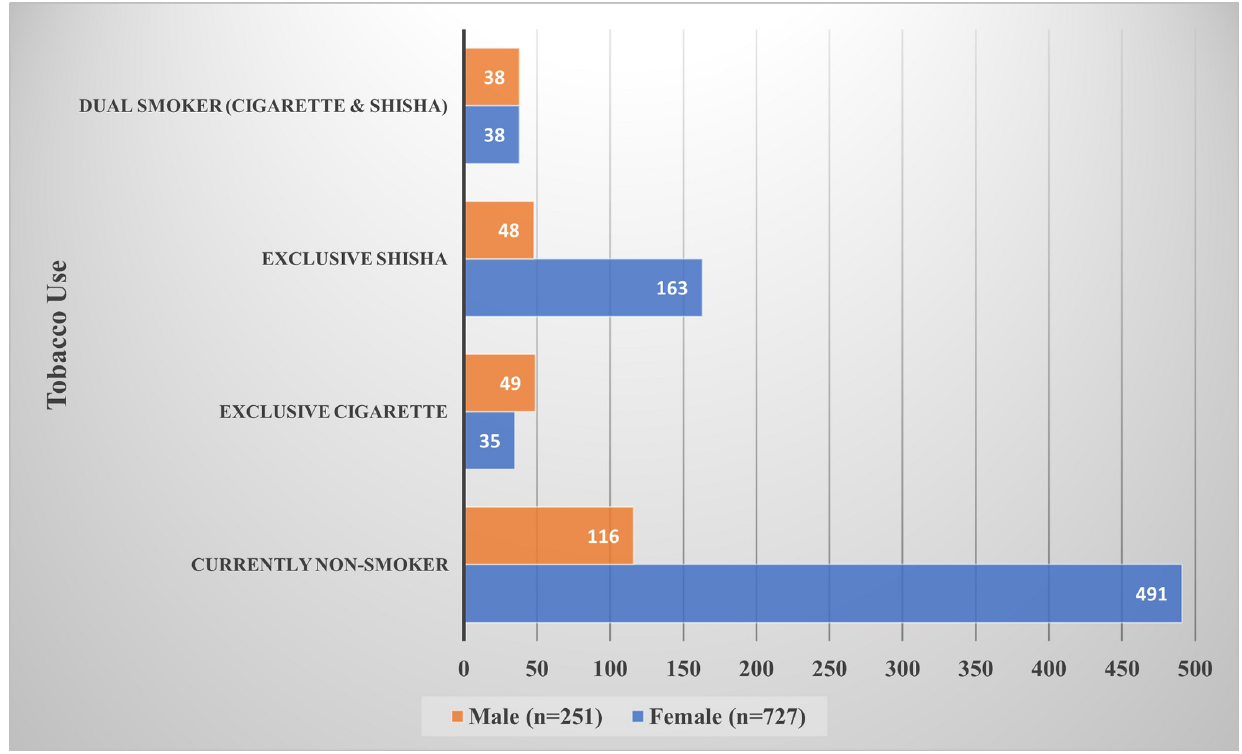
Fig 1. Current tobacco smoking among females and males (frequency